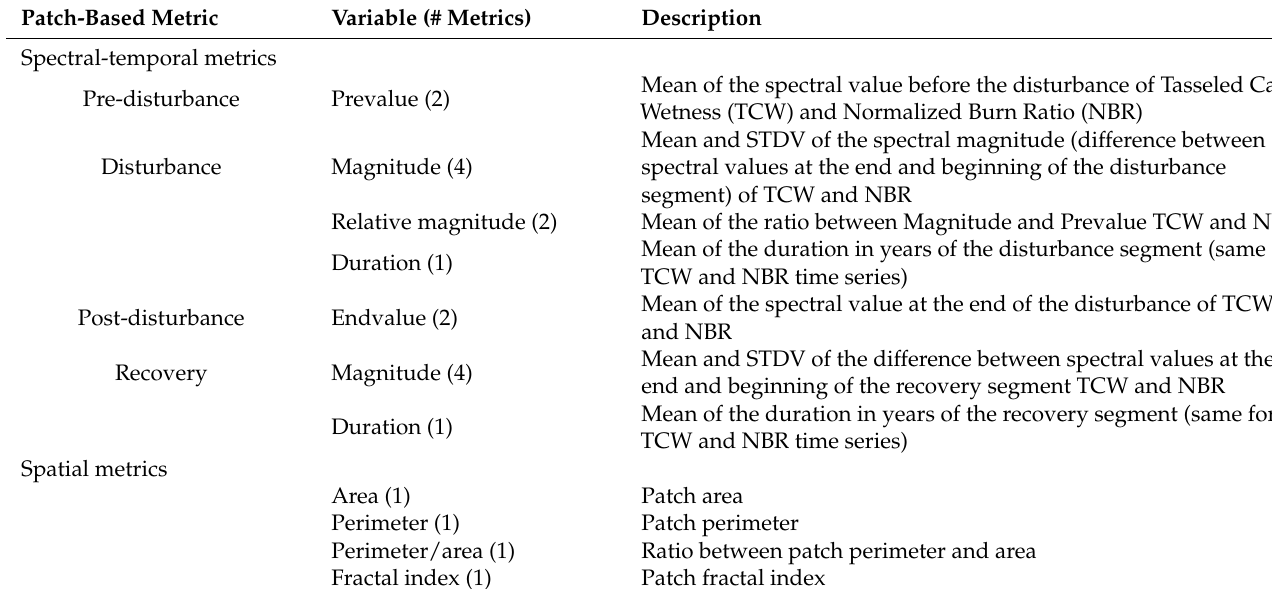
Table 1. Predictor variables calculated for each disturbance patch used for random forests modeling of disturbance